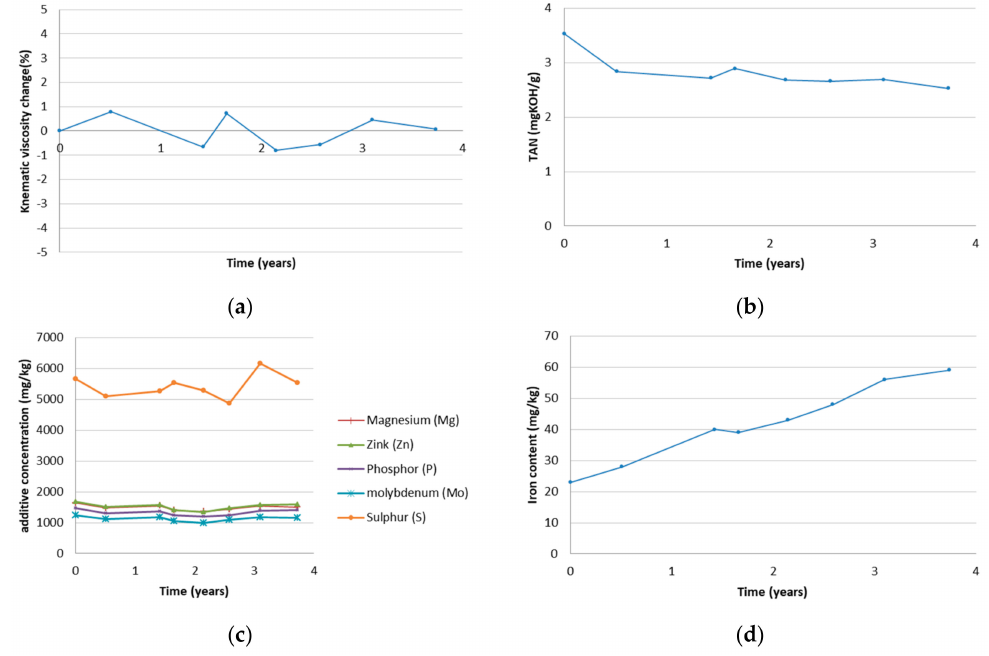
Figure 6. Sampling results of PAO II during the period of analysis. ( a ) Changes in the kinematic viscosity; ( b ) TAN; ( c ) additive content measured by the ICP method; ( d ) iron content measured by the ICP